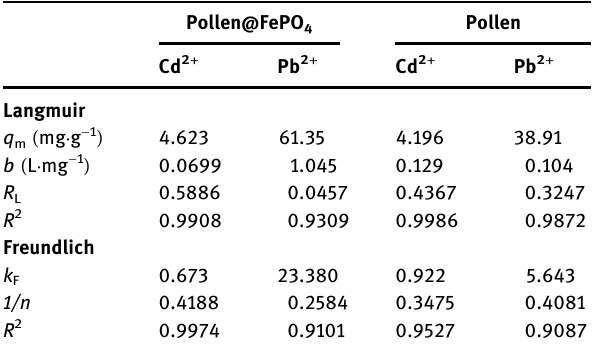
Table 2: Adsorption isotherm constants and correlation coe ffi